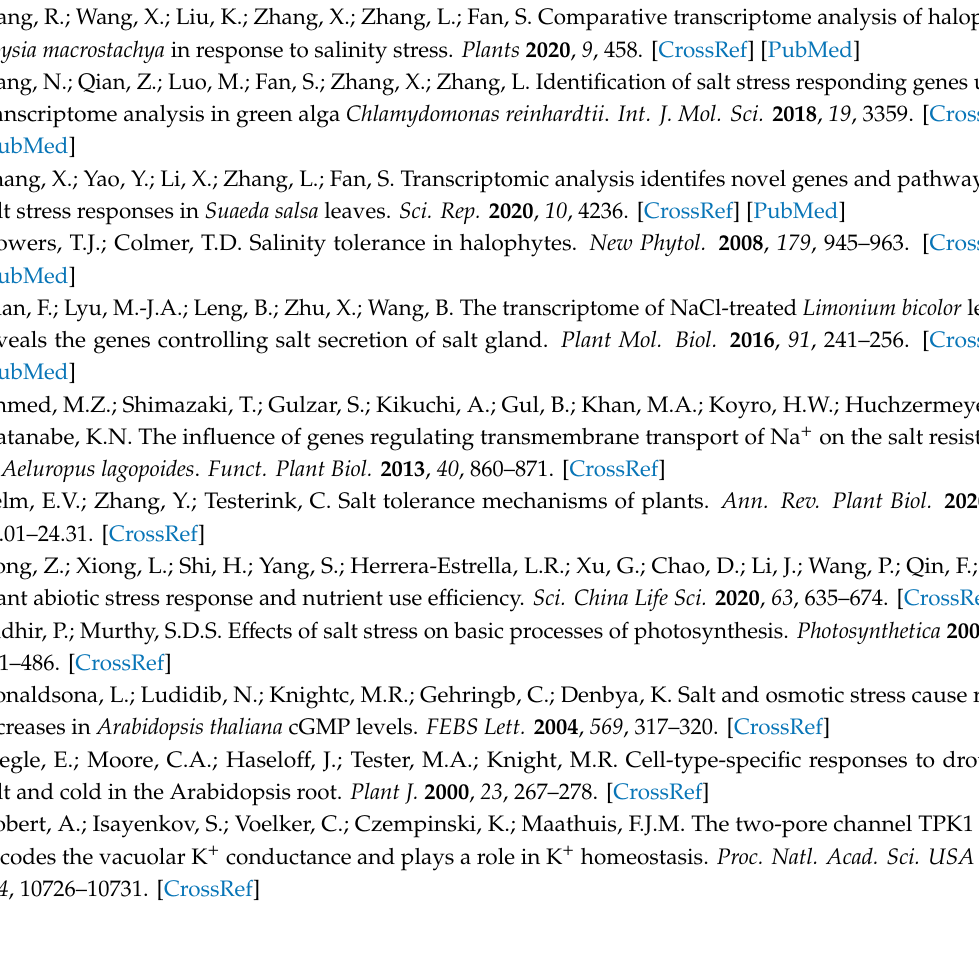
Figure S1. REVIGO analysis results for genes downregulated in B. distachyon under salt stress, Figure S2. ABA and BRs signal transduction pathway, Table S1: Information of the 3120 upregulated and 996 downregulated unigenes in B. distachyon , Table S2: GO enrichment analysis of genes di ff erentially expressed in B. distachyon under salt stress, Table S3: The MapMan pathways enrichment results of the dysregulated genes in B. distachyon , Table S4: KEGG enrichment analysis of genes di ff erentially expressed in B. distachyon under salt stress, Table S5: Transcription factors di ff erentially expressed under salt stress in B. distachyon , Table S6: The information of the qRT–PCR